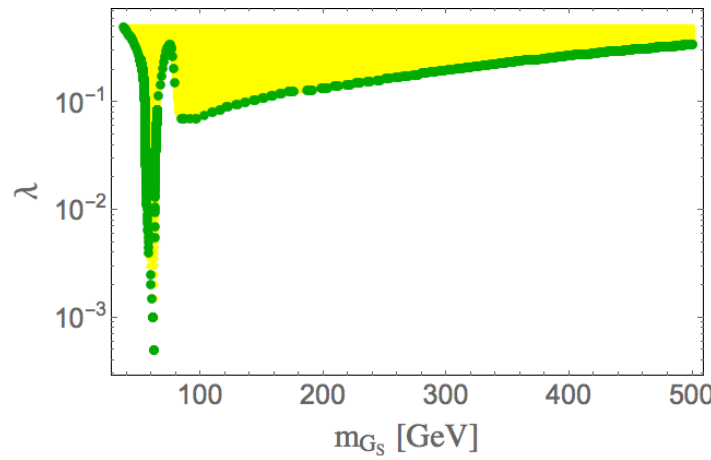
Figure 4 . Regions of the m G (cid:0) (cid:21) plane allowed by the relic density constraint by PLANCK [2] S when all 15 pNBGs are degenerate is shown in green. Under abundant region is shown in yellow. We choose tan (cid:12) = 10 with (cid:11) = (cid:12) + (cid:25)=